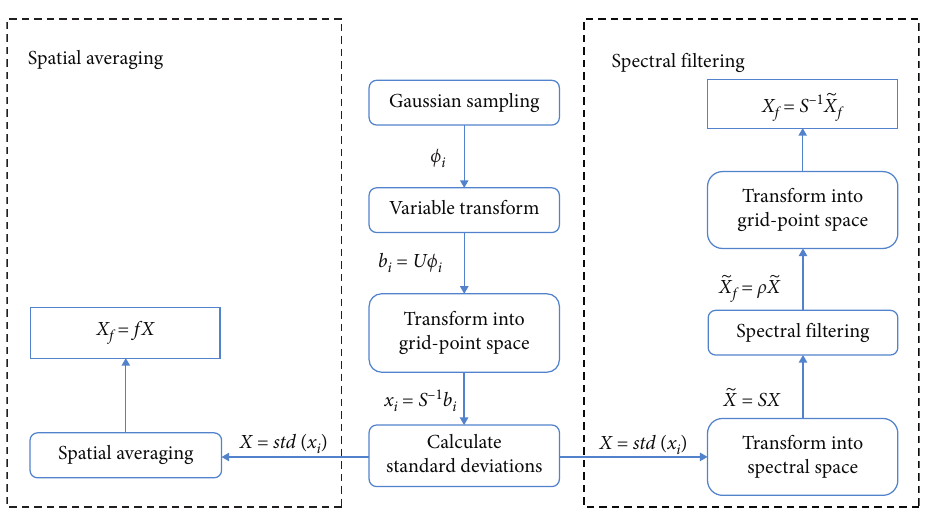
Figure 6: The flowchart of the standard deviation diagnostic procedure.